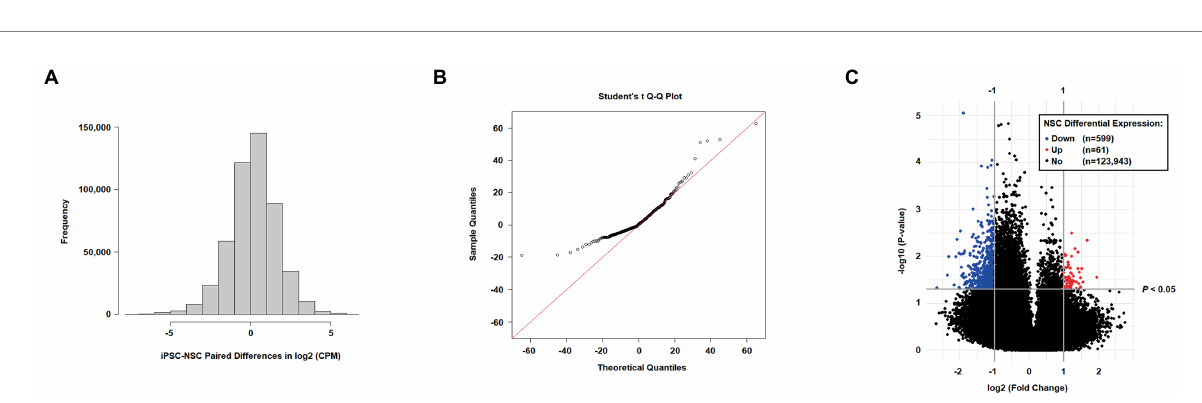
hydroxymethylated sites exhibit reduced 5hmC levels in NSCs, and most are located within a transcription factor binding site (TFBS) or enhancer-like signature, as identified by ENCODE. The DhMRs between iPSC and NSC cell lines were identified using a sliding window computation of Fisher’s combined probability test of one-sided t -test p values for reduced NSC 5hmC expression.